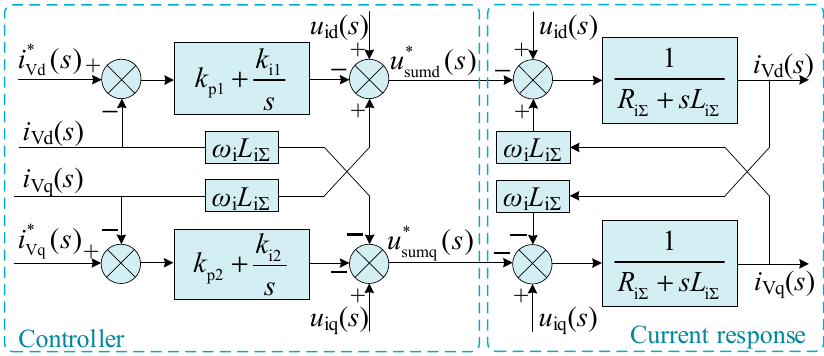
Figure 3. Block diagram of current tracking controller on input side of M3C.